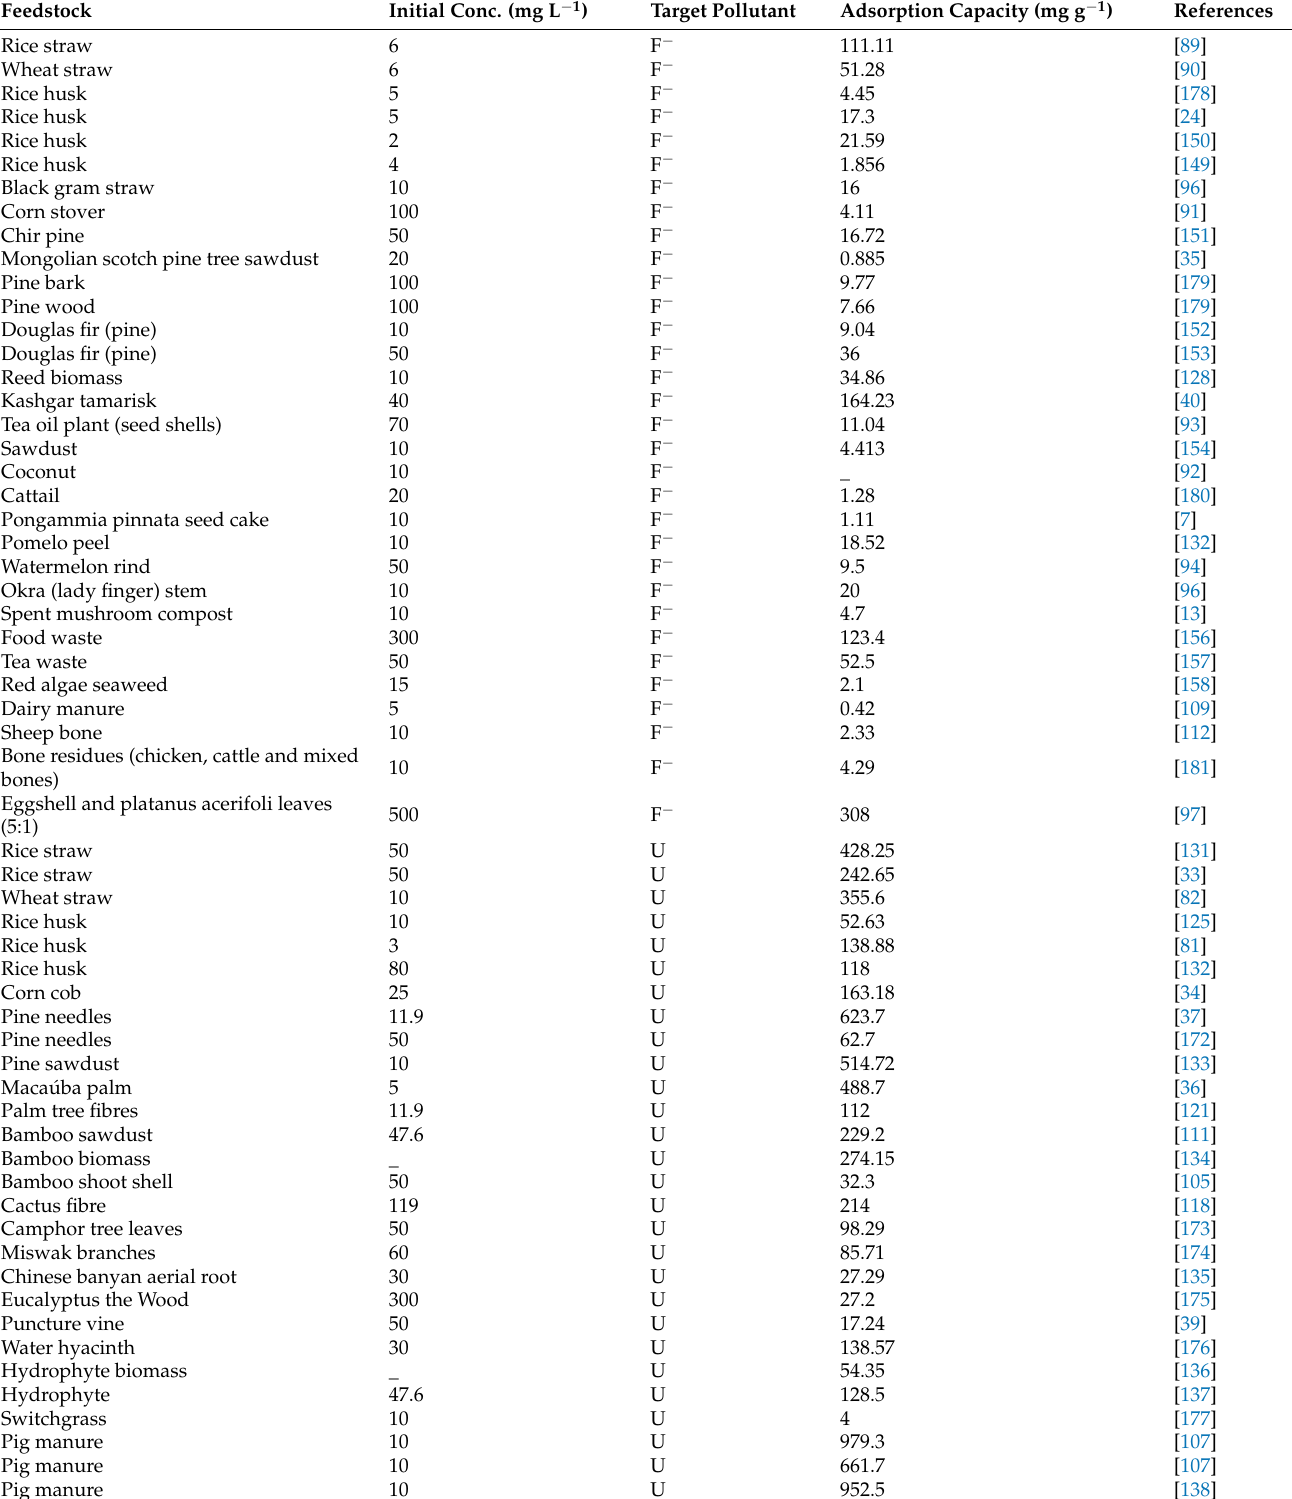
Table 5. Influence of initial concentration on adsorption of F − and